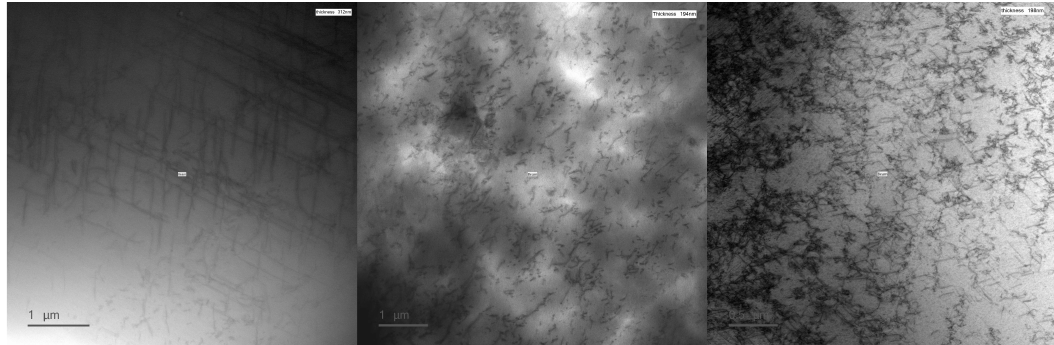
Figure 12. Micrographs obtained using TEM for three samples of M270-35A silicon steel. ( Left ) unstrained sample. ( Middle ) Sample strained to 4.5% and afterwards released. ( Right ) Sample strained to 10.4% and afterwards released.